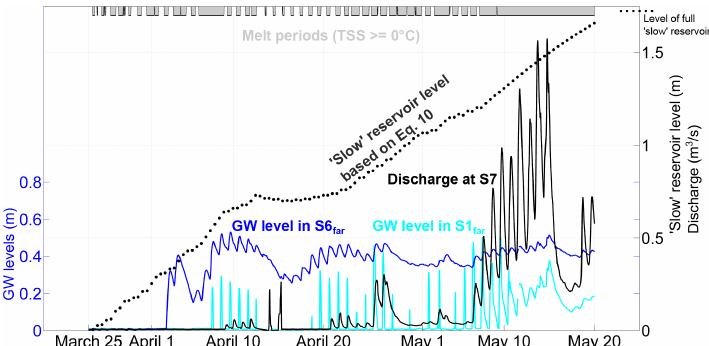
Figure 6. Recharge of the “slow” reservoir from snowmelt in spring 2011. Snowmelt periods (non-negative snow surface temperature) are indicated as grey shading. Groundwater levels, displayed in blue, represent the depth of water in each piezometer. Total discharge and reservoir depth are plotted in black. Reservoir level is computed using Eq. (10) based on a surface area of 400 by 1000m. The corresponding level of the full reservoir is indicated (dotted line).